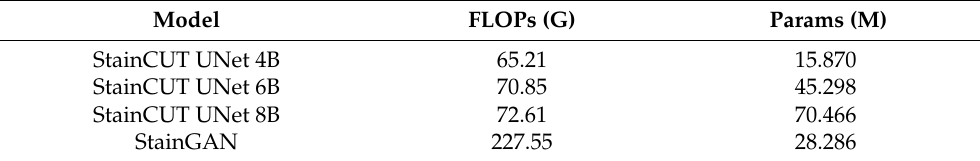
Table 2. Floating point operations (FLOPs) performed in every forward pass and number of param- eters in the generators of the compared deep–learning architectures. The input size for the FLOPs computation was 512 512. For the StainGAN, only the FLOPs and the parameters that correspond × to one of the generators are